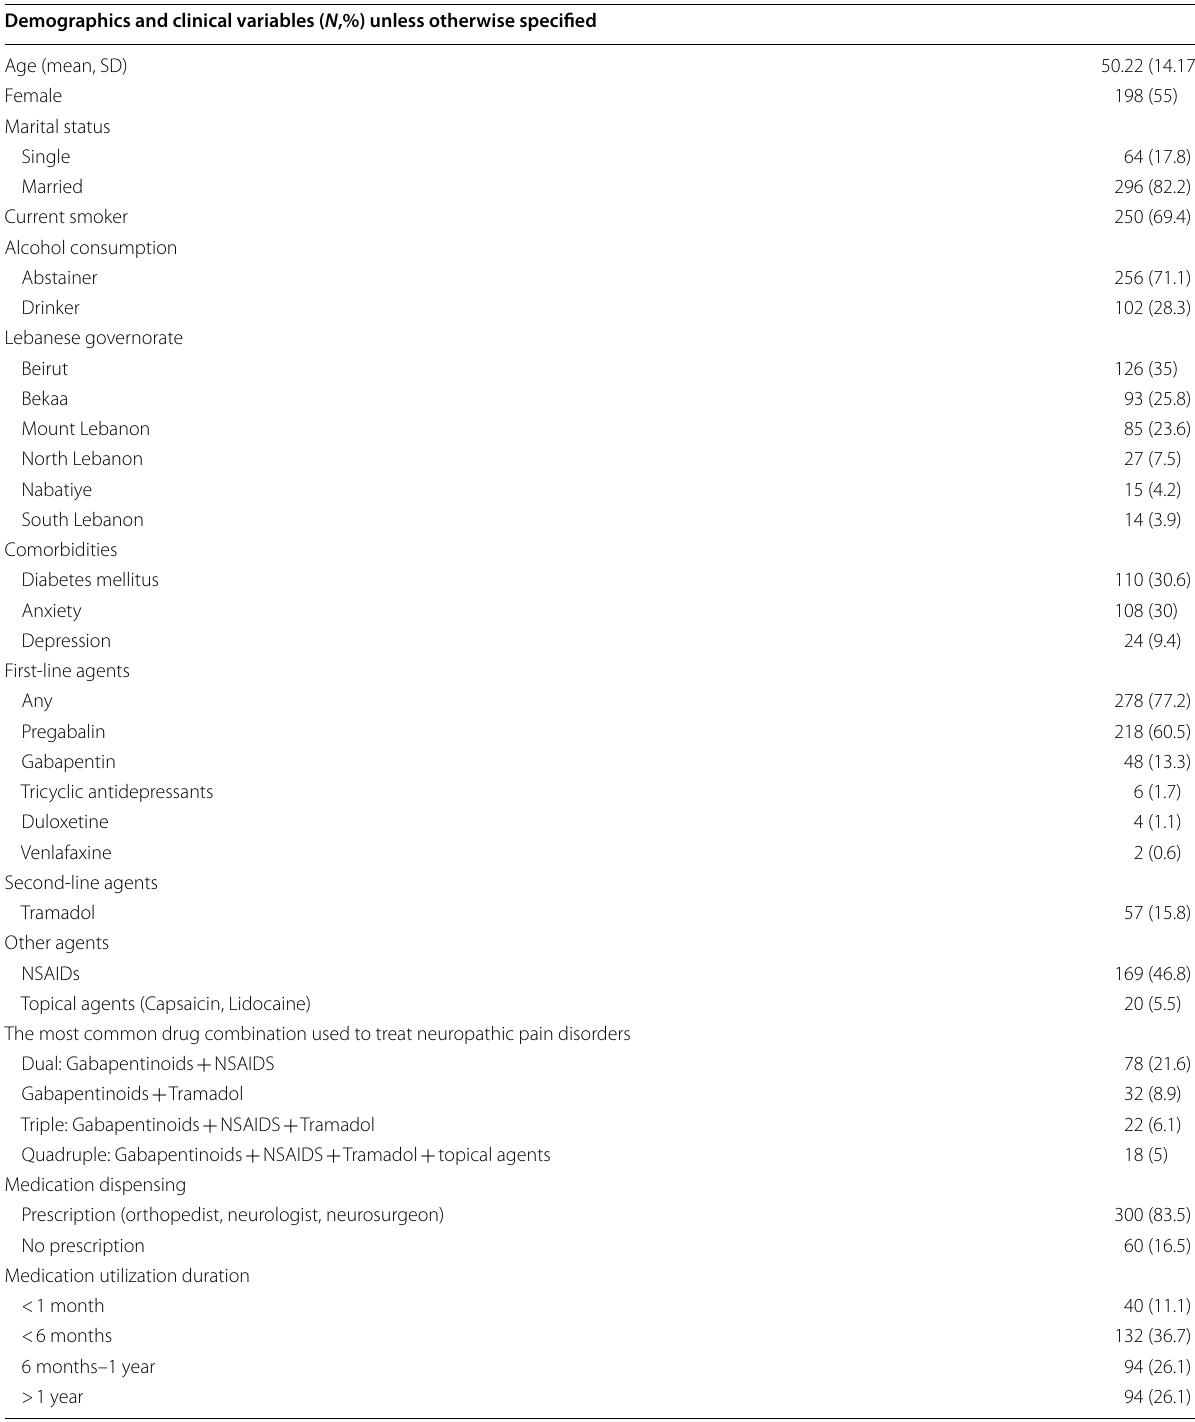
Table 1 Demographic and clinical